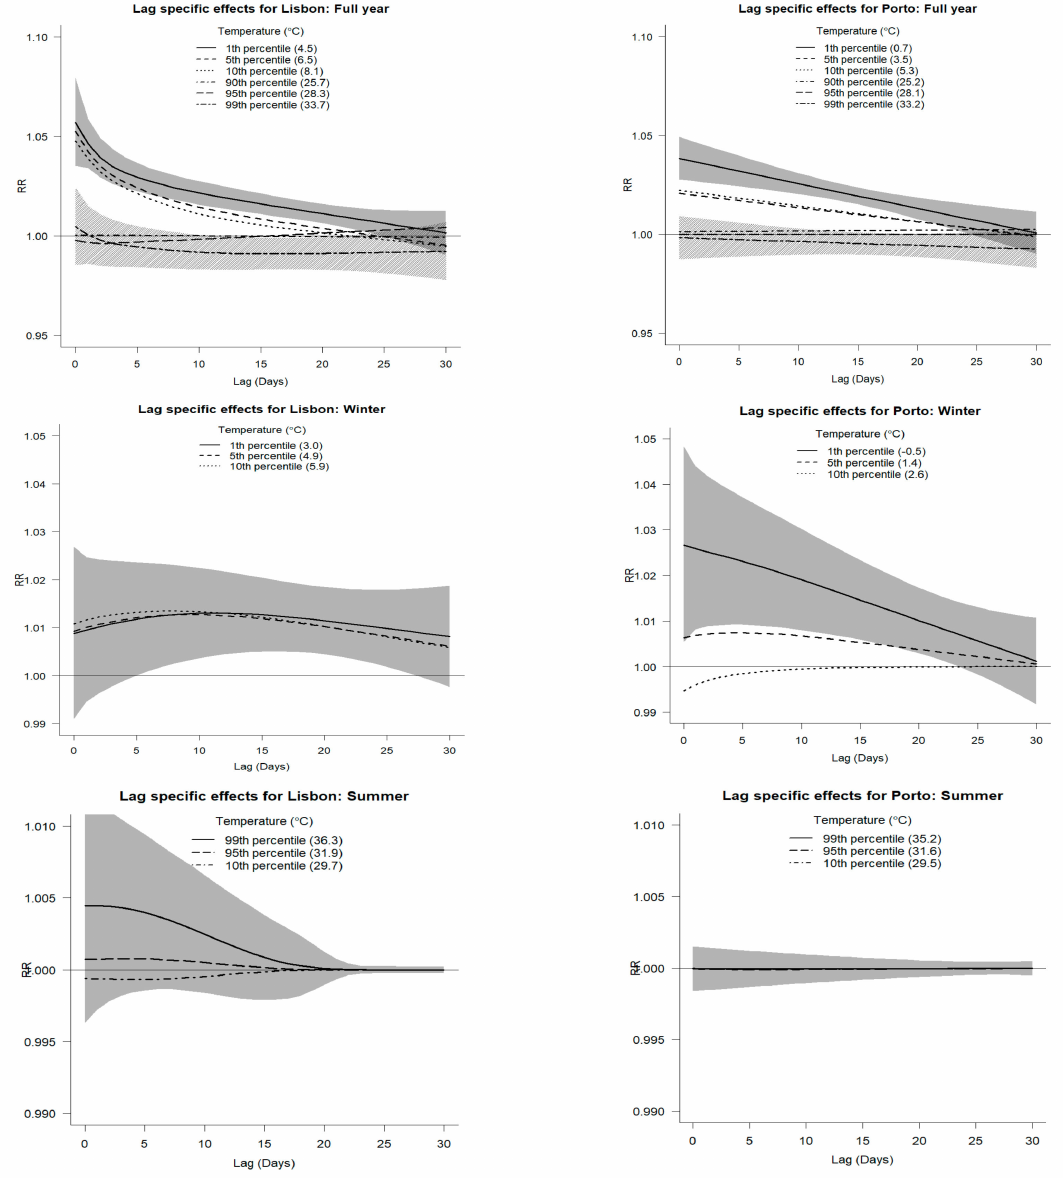
Figure 4. Lag-specific temperature–mortality relationships for lags of 0–30 days under di ff erent models and temperature exposures to 1st, 5th, and 10th temperature percentiles (cold e ff ect) and 90th, 95th, and 99th temperature percentiles (hot temperature e ff ect). The grey regions represent 95% confidence